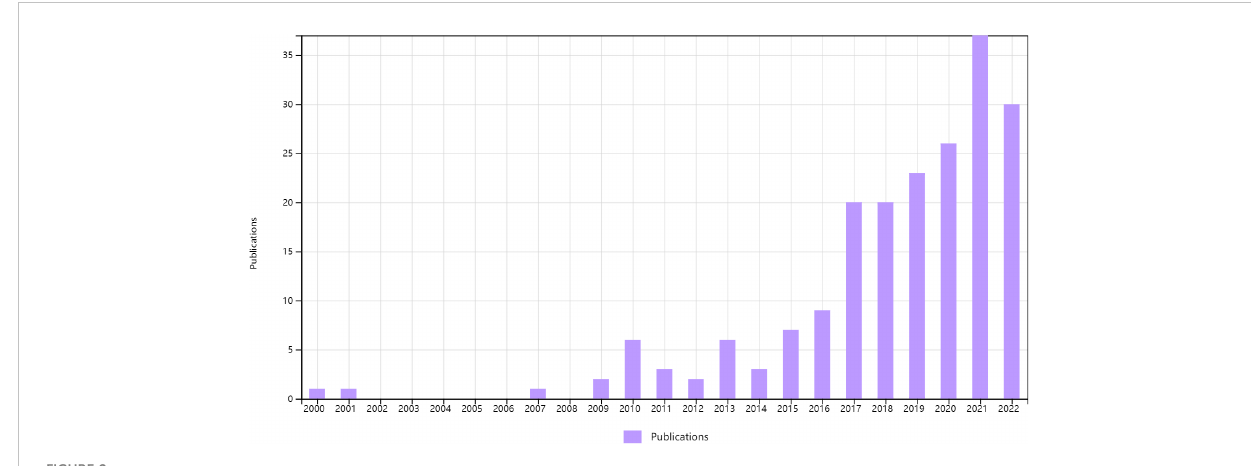
FIGURE 2 Annual publications about machine learning in NSCLC